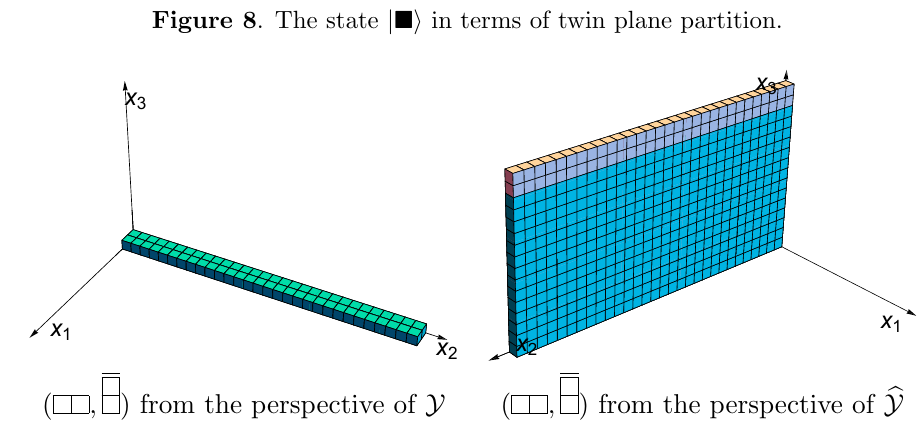
(cid:4)(cid:4) 1 i in terms of twin plane j